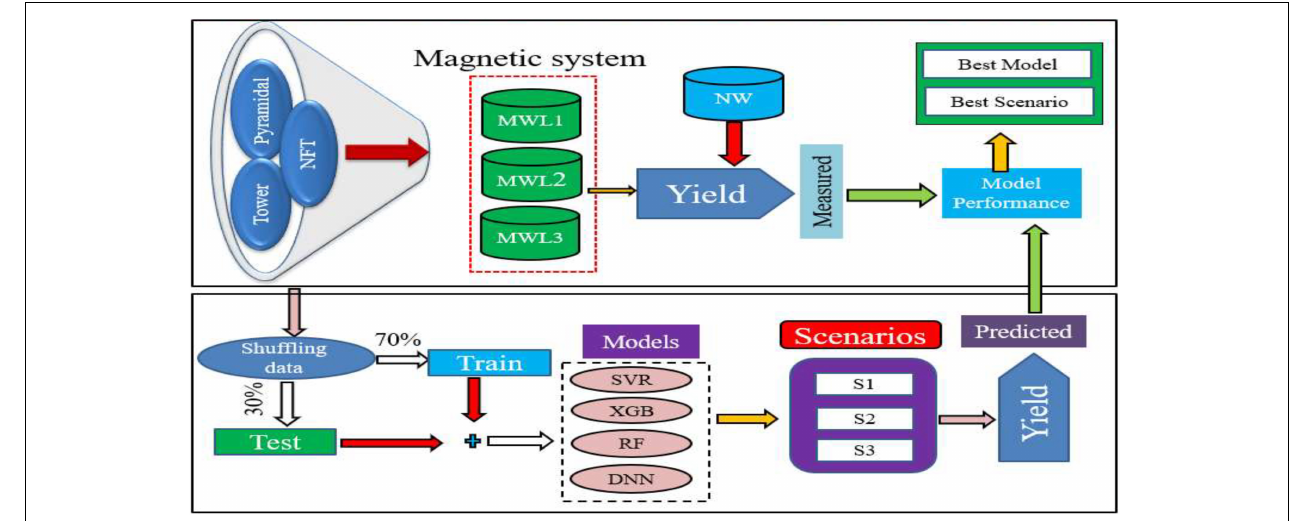
FIGURE 2 | Flowchart of the treatments implemented and models applied.